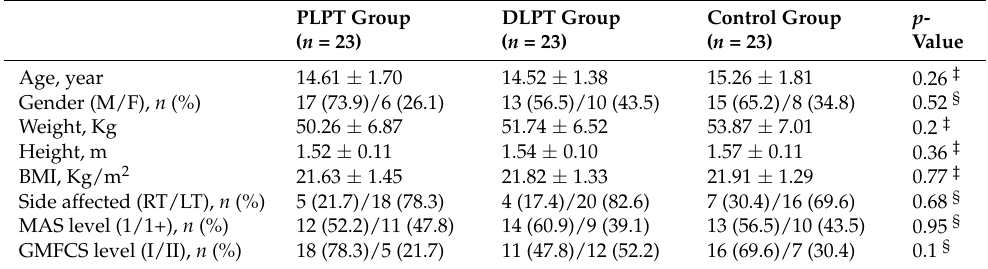
Table 2. Characteristics (demographic and clinical) of participants in the study groups.